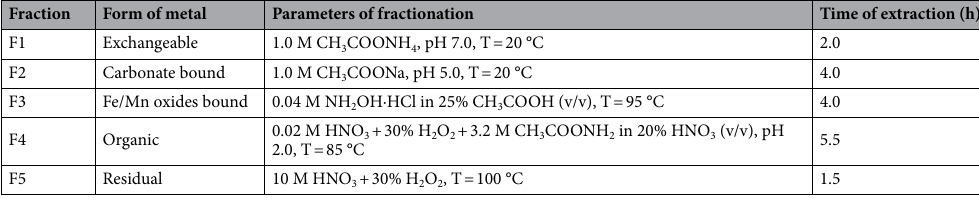
Table 1. Method of metal speciation in coal and ES